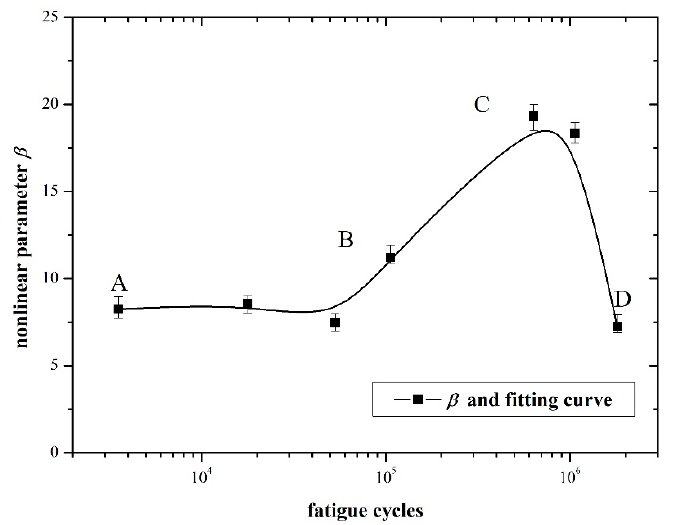
Figure 7. Relationship curve between nonlinear coefficient and fatigue cycles of the KMN vibra- tion fatigue specimen. ( R 2 = 0.93). fatigue specimen. ( R 2 =